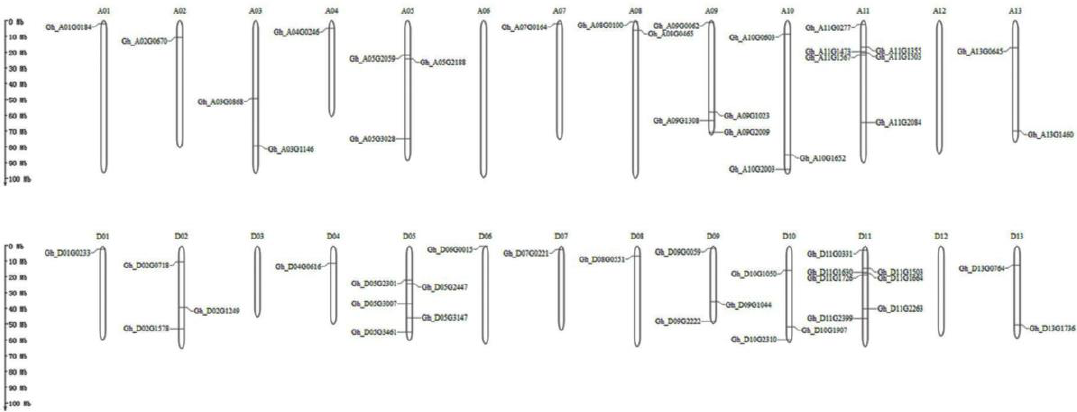
Figure 4. Chromosomal distribution of RCC1 genes in G. hirsutum . The chromosome number is located directly above each vertical bar. Two genes were found on unassembled scaffolds ( Gh_D08G2751 and Gh_A11G3194 ). The scale is in Mb.